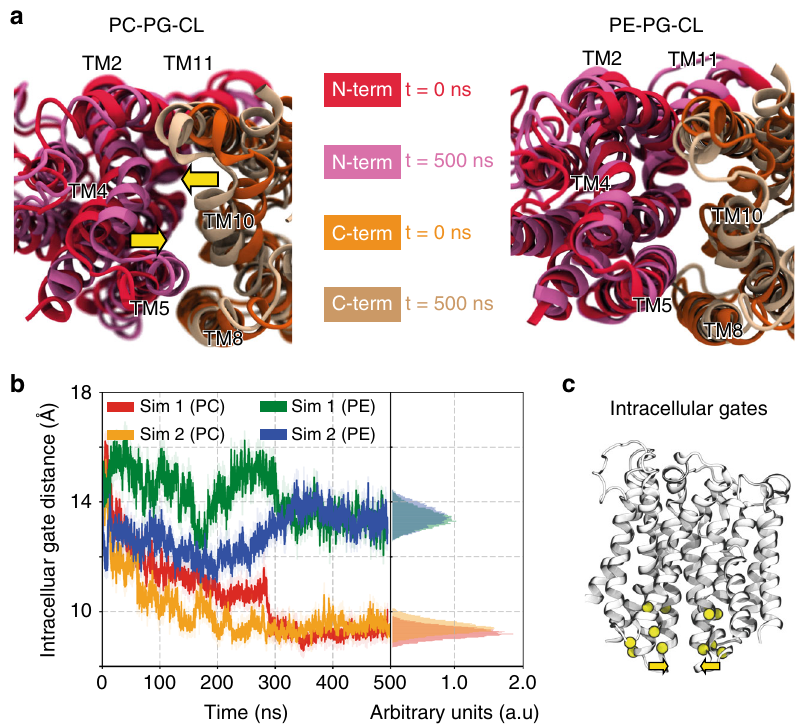
Fig. 5 Closing of the intracellular side of XylE in PC:PG:CL bilayers. MD simulations predict different conformational changes of XylE in PC vs. PE bilayers. a Representative snapshots at the beginning (t = 0 ns) and end of the simulation (t = 500 ns) show a closing of the intracellular side in PC nanodisc (left) compared to PE nanodisc (right). b Time trace showing the intracellular gate distance over simulation time. PC simulation sets are coloured orange and red, while the PE simulation sets are coloured green and blue. The inset on the right depicts the normalized distribution of the intracellular gate distance for the last 200 ns of the trajectory. c Snapshot describing the de fi nition of the intracellular gates in XylE. The intracellular gating distance is de fi ned as the center of mass (COM) distance between the two groups of Ca-Ca residues: group1 residues (75 – 80, 149 – 154, 160 – 16) and group2